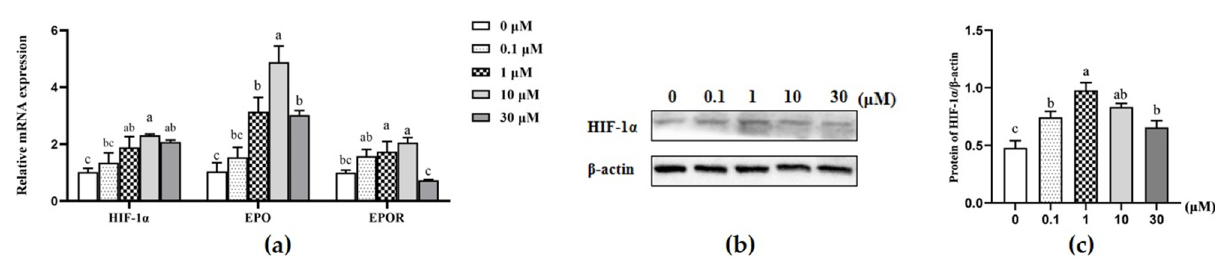
Figure 5. Effects of β -sitosterol on the expression levels of HIF-1 α and related factors in MAC-T cells. ( a ) mRNA expression